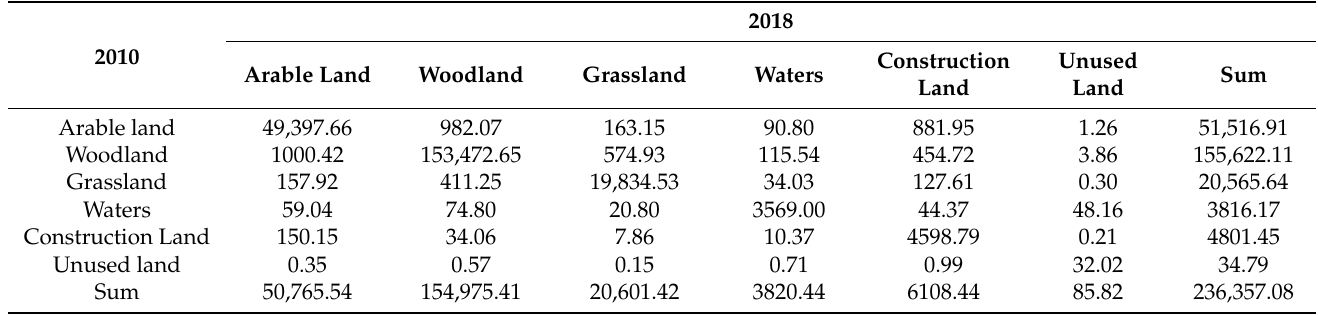
Table 4. Matrix of land-use types transfer in Guangxi from 2010 to 2018 (unit: km 2 ).